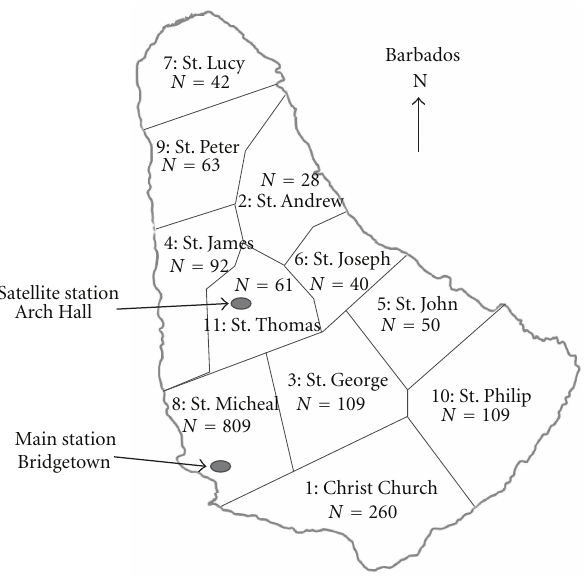
Figure 1: Schematic of the map of Barbados showing the number of Non-transported calls to the Barbados Ambulance Service by parish during January to September